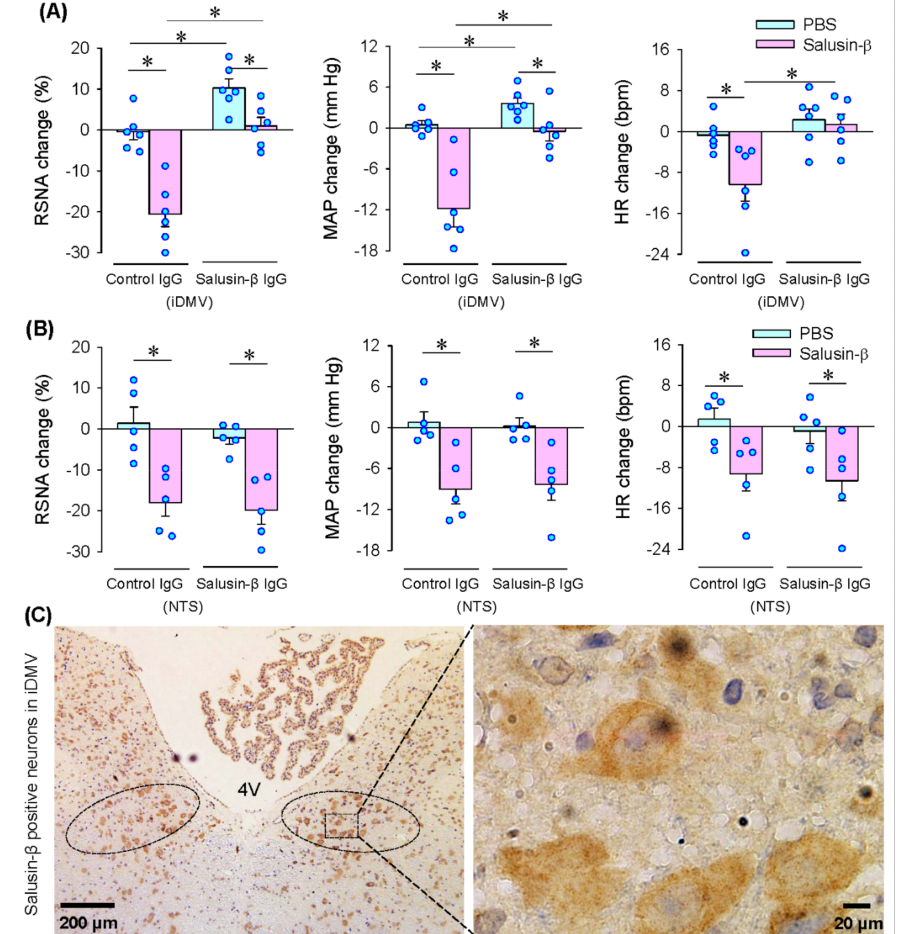
Figure 4. Roles of neutralization of salusin- β with antibody in iDMV or NTS and salusin- β expression in iDMV. ( A ) Effects of microinjection of control IgG (100 ng) or salusin- β IgG (100 ng) in the iDMV on the salusin- β -induced RSNA, MAP and HR changes. The pretreatment with IgG in the iDMV was carried out 10 min before microinjection of salusin- β (100 pmol) in the iDMV. ( B ) Effects of microinjection of control IgG (100 ng) or salusin- β IgG (100 ng) in the NTS on the salusin- β - induced RSNA, MAP and HR changes. The pretreatment with IgG in the NTS was carried out 10 min before microinjection of salusin- β (100 pmol) in the iDMV. ( C ) Representative images of immunohistochemistry for salusin- β (brown color) iDMV. 4V, the fourth ventricle. * p <